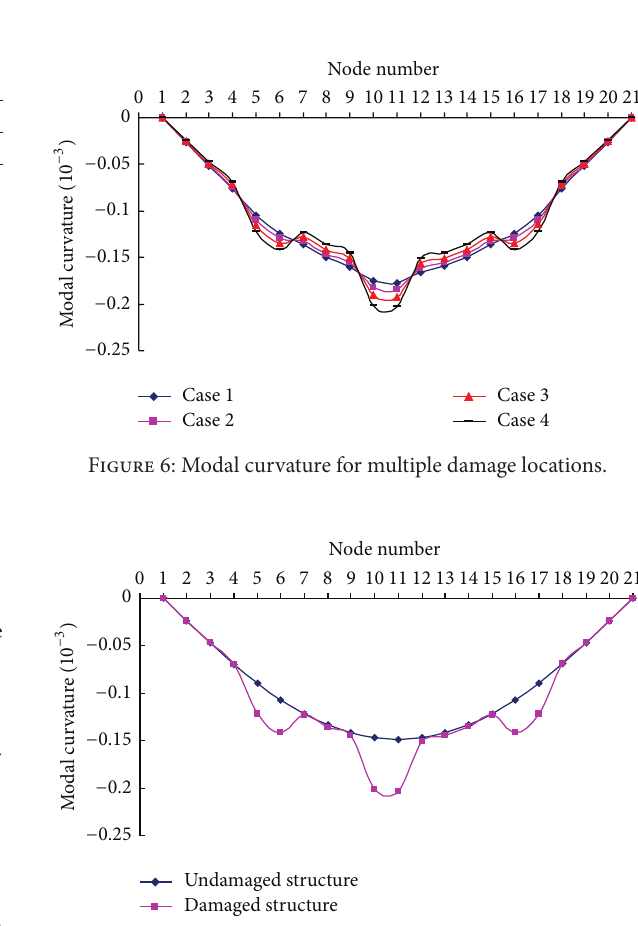
Figure 7: Modal curvature of undamaged structure obtained by Chebyshev polynomial fitting for damage identification with multiple